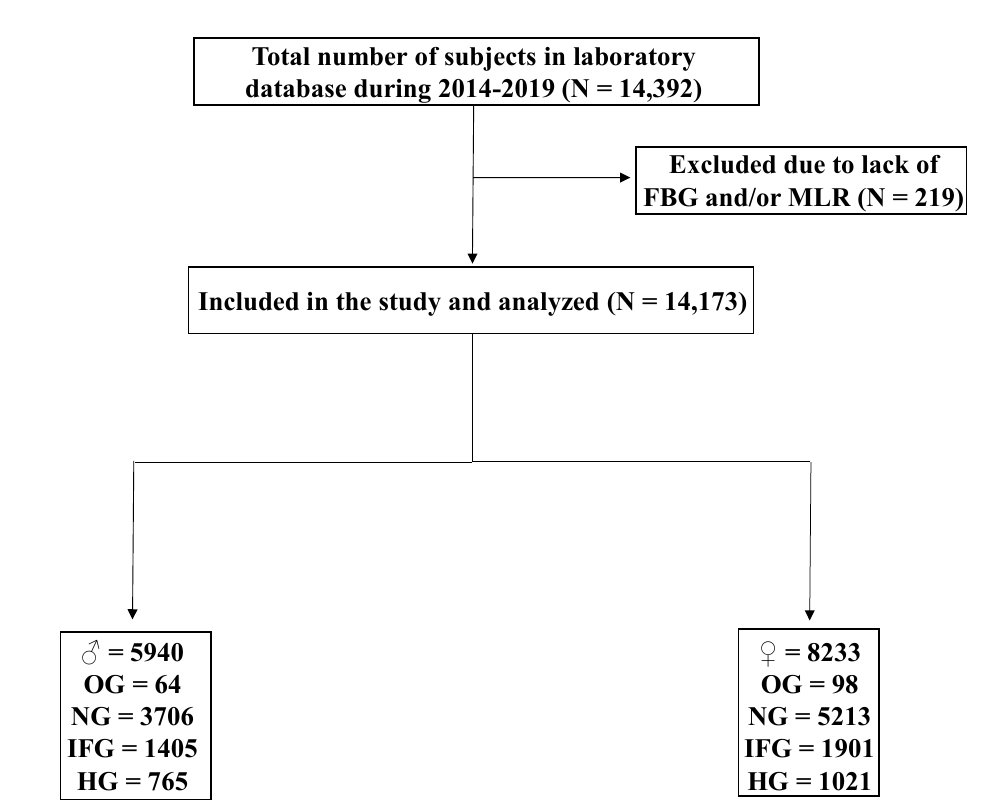
Figure 1. A flow chart of study design.